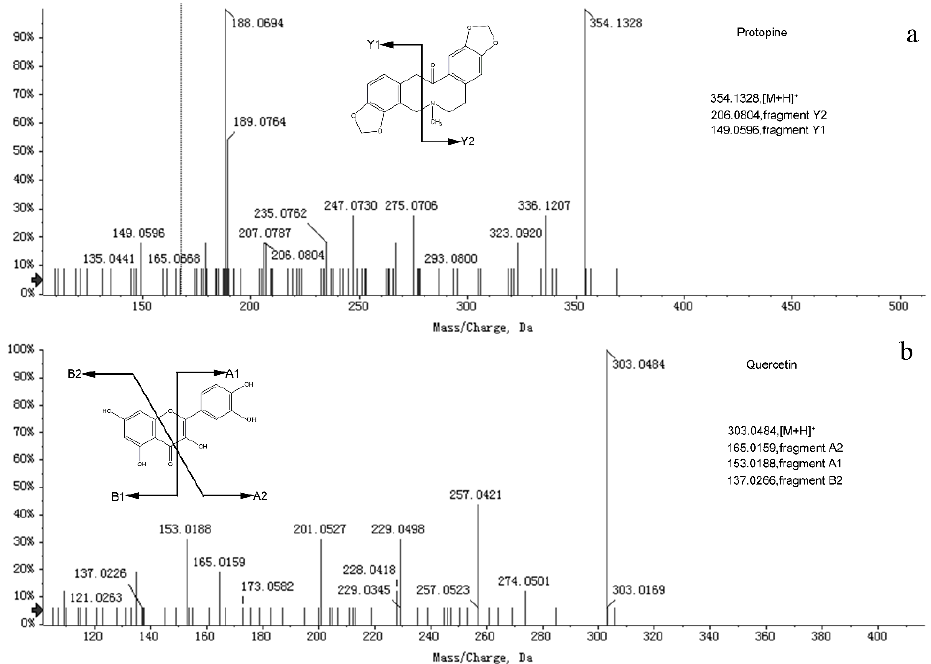
Figure 1. MS/MS spectra in positive mode of protopine ( a ) and quercetin( b